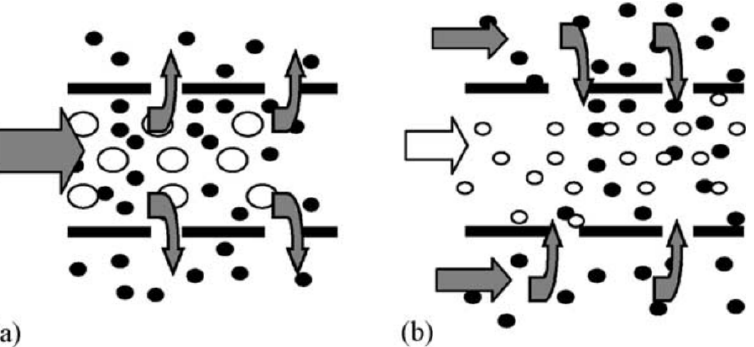
Figure 7. Principles of obtaining NPs through membrane dispersion (the balls represent the molecules): ( a ) P in > P out , ( b ) P in < P out . Reprinted with permission from ref. [104]. Copyright 2002 Elsevier. Zhiqian and Zhongzhou obtained BaSO 4 NPs by using a membrane reactor, in which the Na 2 SO 4 solution permeated through the micropores of the ultrafiltration membrane gradually into BaCl 2 solution [104]. Under the optimized conditions (SO 42 − /Ba 2+ molar ratio of 2; membrane molecular weight cut-off of 1000; transmembrane pressures of 0.010 MPa; linear flow rate of 0.589 m/s; the absolute temperature of 288 K; concentration of BaCl 2 of 0.005 mol/L; the initial volume of BaCl 2 solutions of 80 mL), the size of obtained BaSO 4 NPs was ~60 nm.